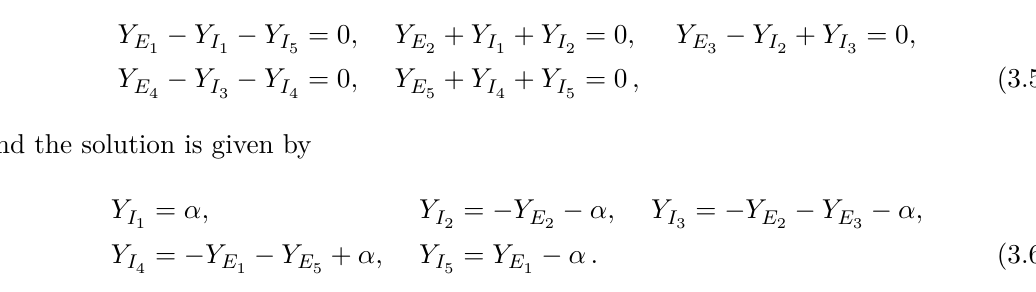
Table 5 . The hypercharge of each internal line for the three renormalizable topologies of long-range 0 νββ decay, and the conventions for the hypercharge flows are shown in tables 2, 3 and 4. Similar to previous case, the hypercharge is not unambiguously fixed, and the arbitrariness is encoded in the real free parameter α . For the last topology NL-1-3 with labels defined in table 4, the gauge invariance under U(1) leads to the following Y